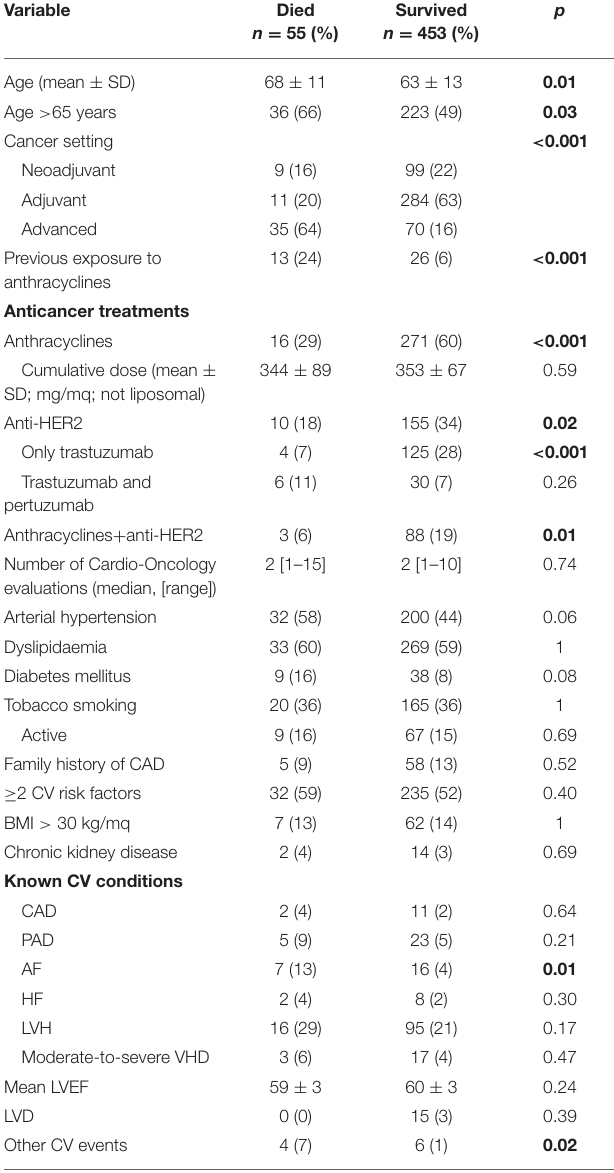
TABLE 4 | Characteristics of BC patients who died at follow-up and who survived.